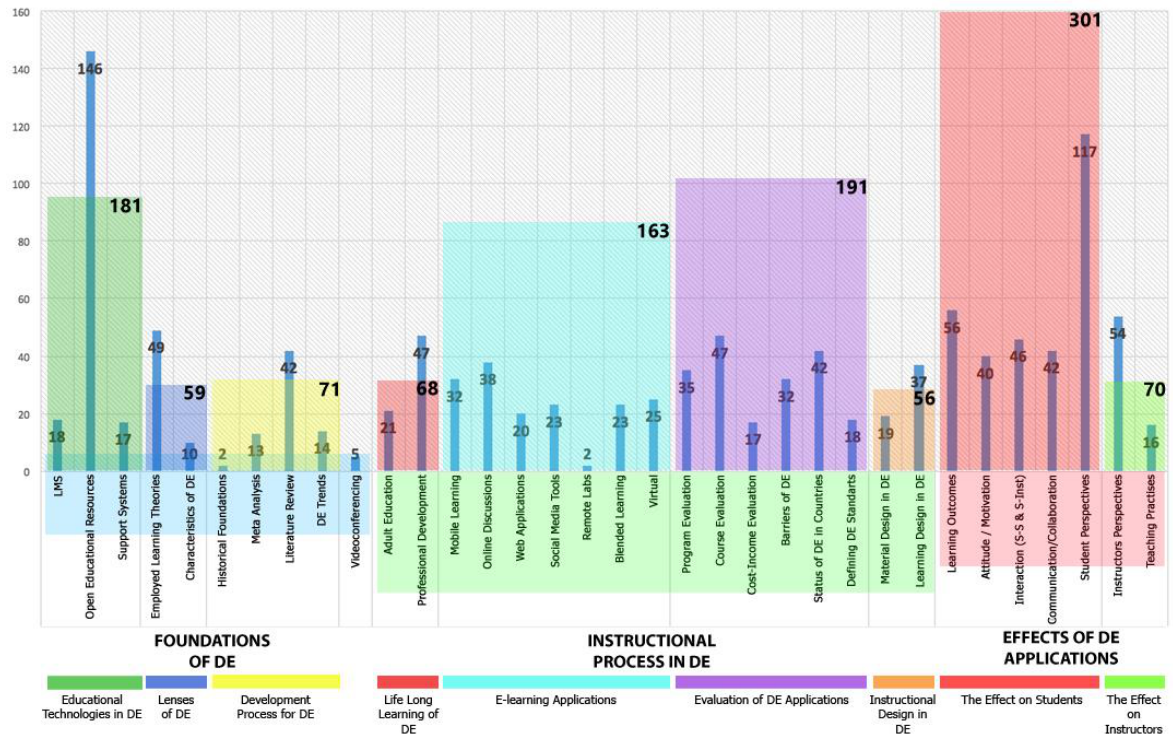
Figure 4. The trends in research topics in distance learning articles published from 2009 to